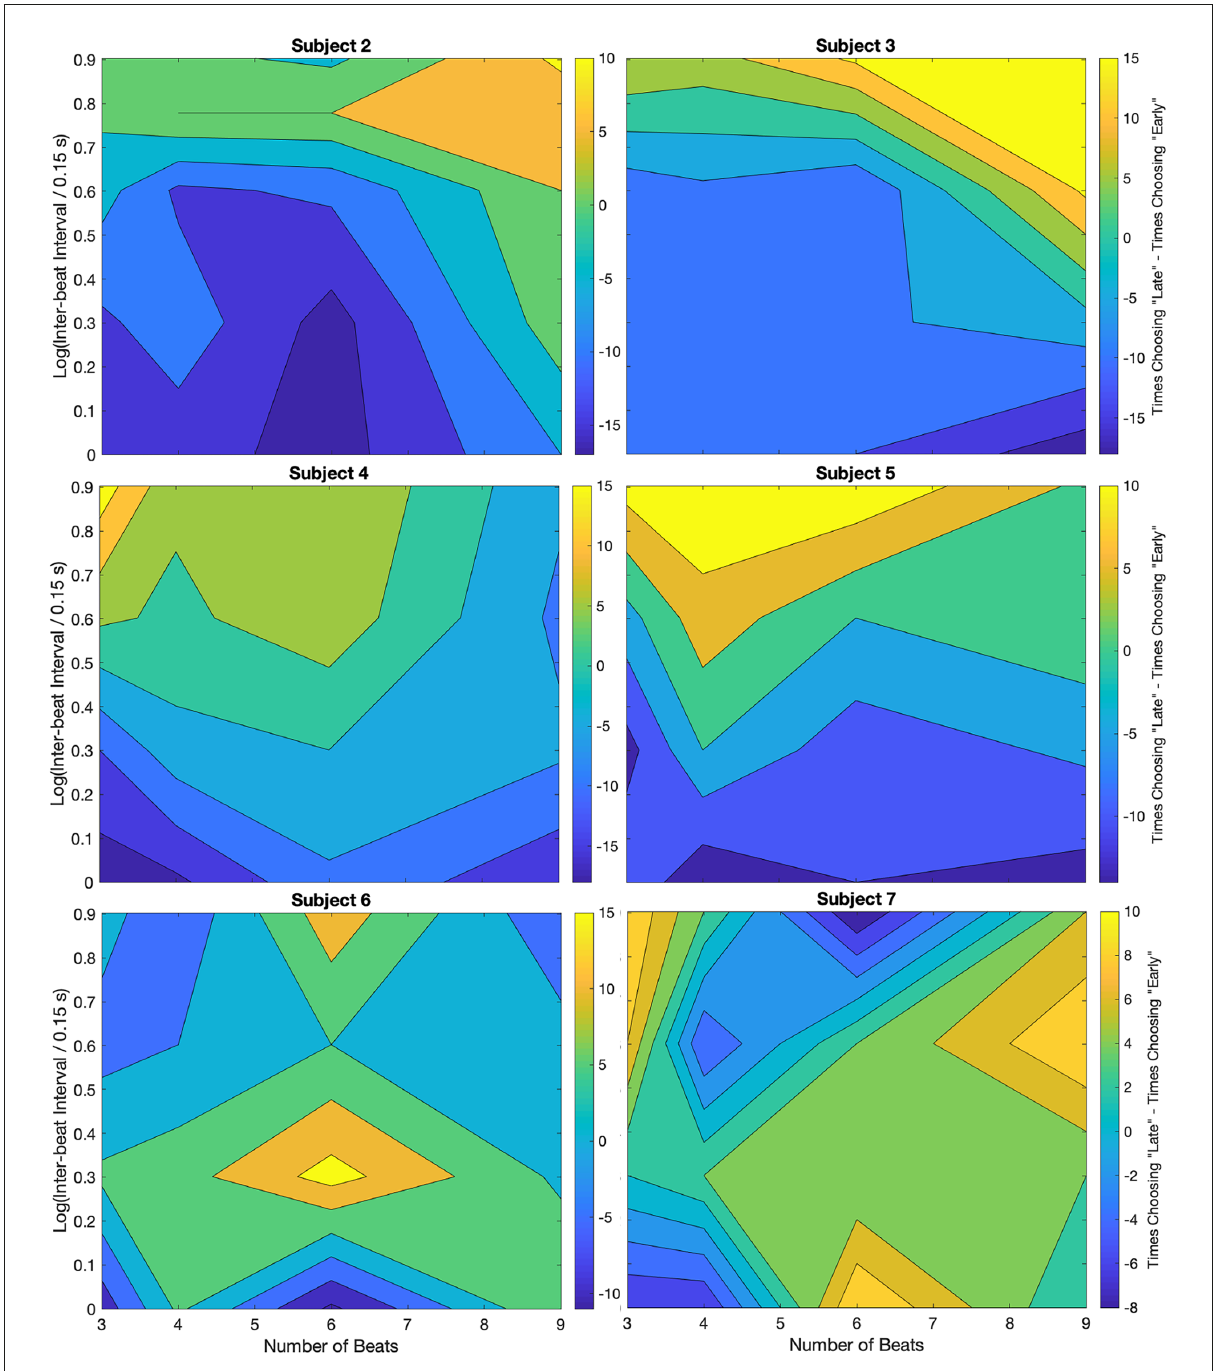
FIGURE6 Individuality demonstrated through the non-zero-deviation data for different subjects. Plot conventions are the same as in Figure 5A . As in that figure, most subjects (2–6) show a bias towards “Early” responses for low inter-beat intervals. Similarly, at larger inter-beat intervals, the bias reverses. However, whereas for some subjects the peak reversal happens at high inter-beat intervals and a large number of beats (Subjects 2 and 3), for others the peak is either at a low number of beats (Subjects 4 and 5) or at intermediate inter-beat intervals (Subject 6). Only one subject showed no bias reversal with the inter-beat interval. We discuss possible reasons for this difference between this subject and others in the